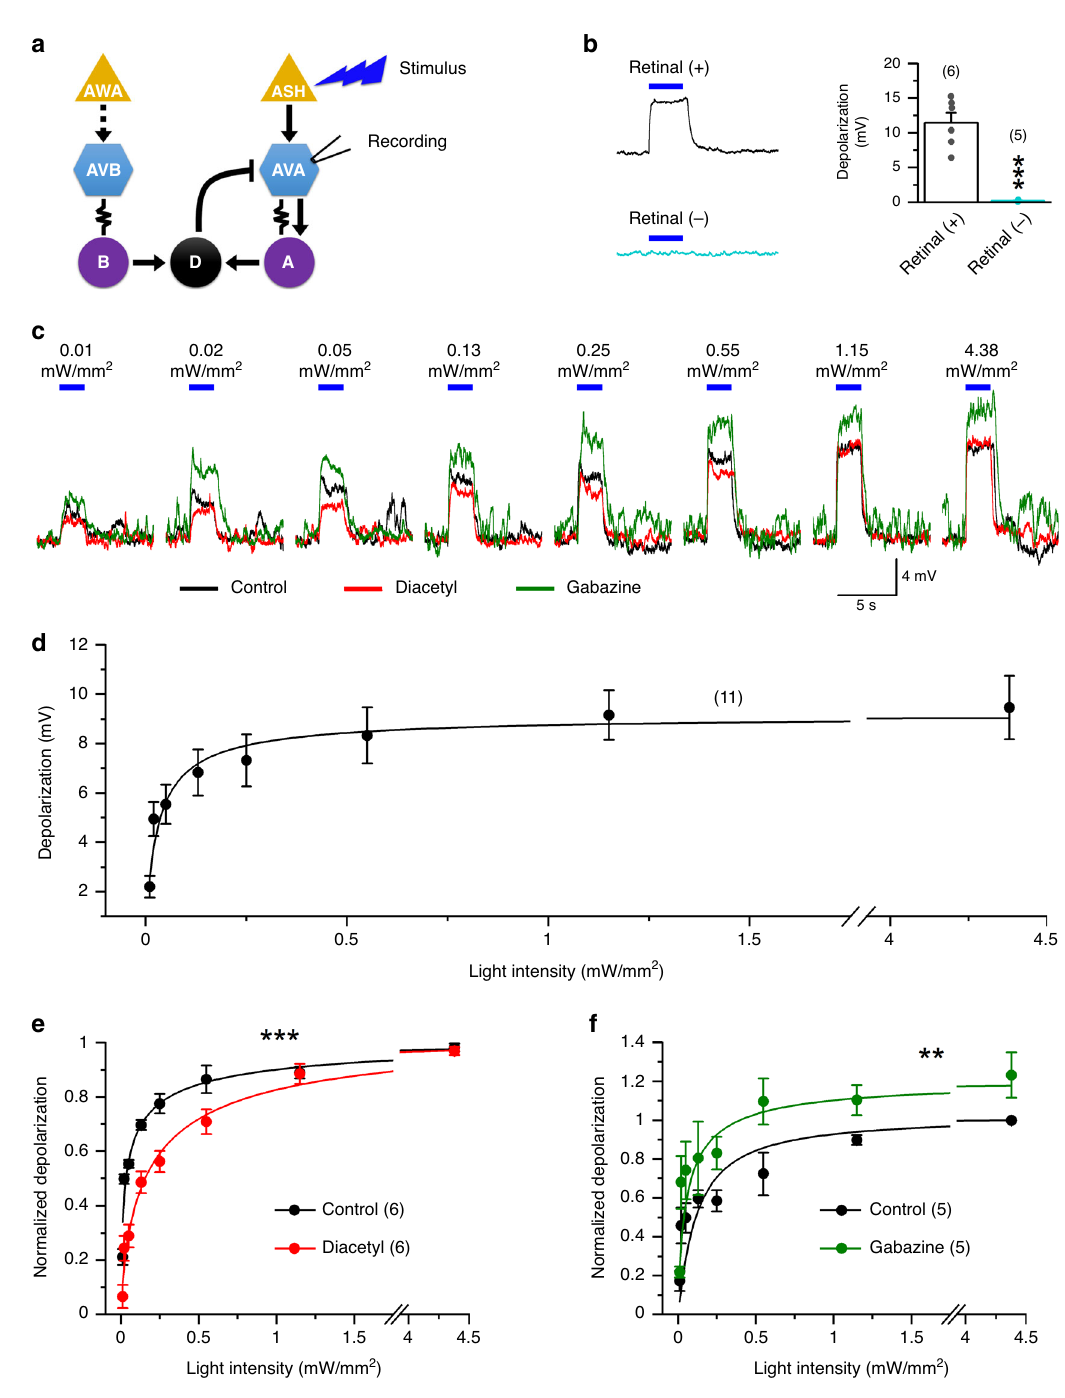
Fig. 6 AVA interneurons are hub neurons integrating signals from diacetyl and glycerol sensory circuits and the D-AVA inhibitory circuit. a Diagram showing the experimental approach. Optogenetically evoked AVA membrane depolarization was recorded in a strain expressing channelrhodopsin-2 speci fi cally in ASH sensory neurons. Either diacetyl (1:1000 dilution) or gabazine (500 µ M) was added to the bath solution between two series of blue light stimuli (0 – 4.5 mW/mm 2 ). b All-trans retinal is required for optogenetically evoked AVA depolarization ( p = 0.000). c Sample traces of blue light-induced AVA membrane voltage change under three different experimental conditions: control, diacetyl, and gabazine. The blue lines mark the periods of light stimuli. The numbers above them indicate light intensities (mW/mm 2 ). d Light intensity and AVA membrane depolarization curve of the control, which was pooled from the diacetyl and gabazine groups. e Light intensity and AVA membrane depolarization curves of the gabazine group normalized to its control (pre-gabazine) peak response. p = 0.001 between the two groups. f Light intensity and AVA membrane depolarization curves of the diacetyl group normalized to its control (pre-diacetyl) peak response. p = 0.009 between the two groups. The asterisk in b indicates a signi fi cant difference compared with the Retinal ( + ) group whereas those in e and f indicate signi fi cant differences compared with the control (** p < 0.01, *** p < 0.001, two-way mixed design ANOVA). The numbers inside brackets indicate sample size ( n ). n = numbers of independently recorded cells. Data are presented as mean values ± SEM. Source data are provided as a Source data fi